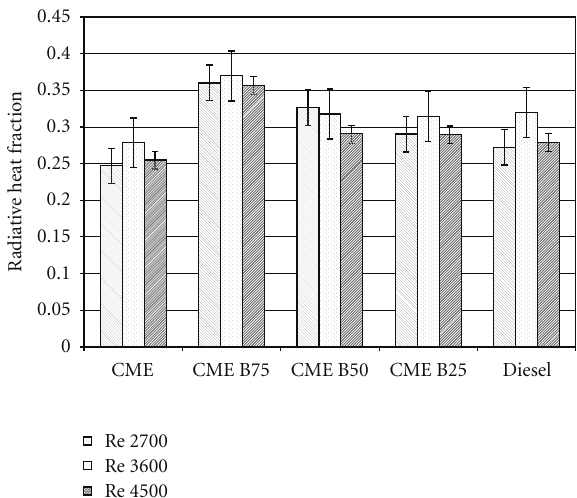
Figure 7: Comparison of radiative heat fraction of the di ff erent flames.